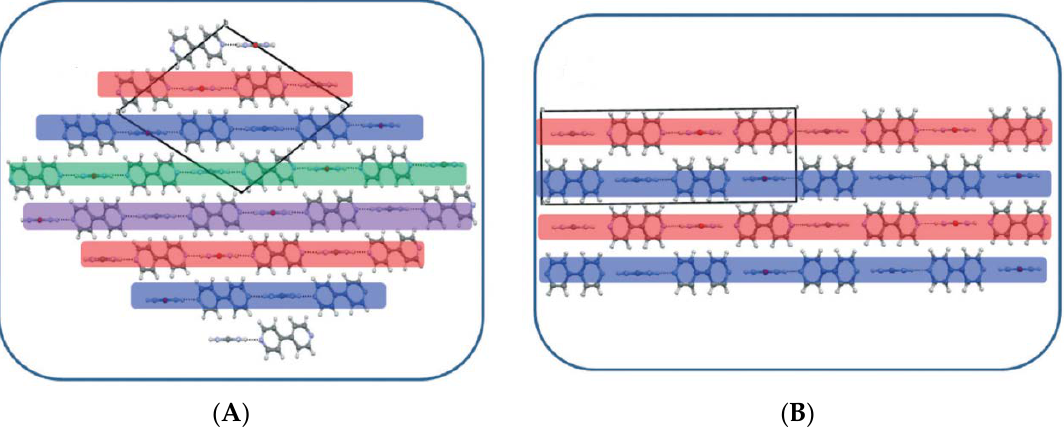
Figure 29. Packing of ( A ) form I urea-4, 4′ -bipyridine (1:1) and ( B ) form IIurea-4, 4′ -bipyridine (1:1) cocrystals [Reprinted from [306] with permission. Copyright 2014 Royal Society of Chemistry].